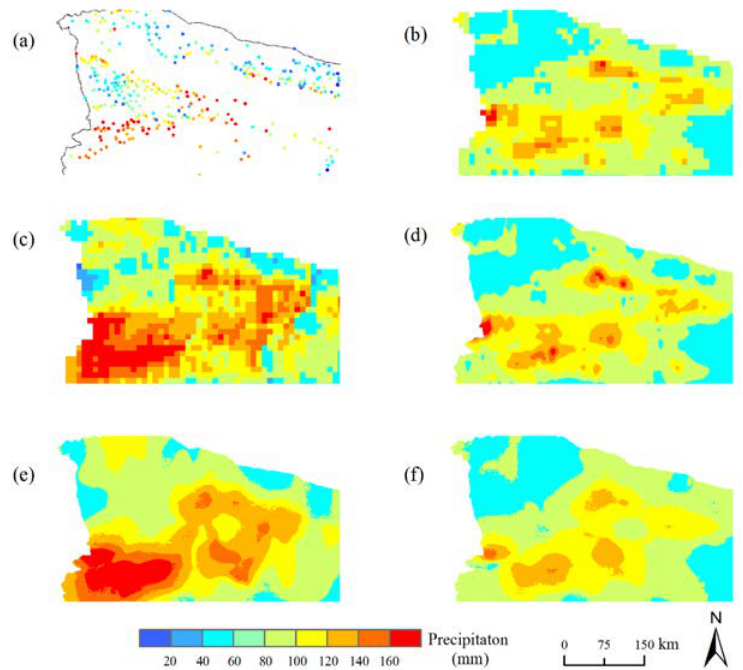
Figure 10. Enlarged views of the Ili Valley corresponding to Figure 9. ( a ) OBS; ( b ) OIMERG; ( c ) CIMERG; (d) DS_Spline; (e) DS_CIMERG; (f) DS_OIMERG.